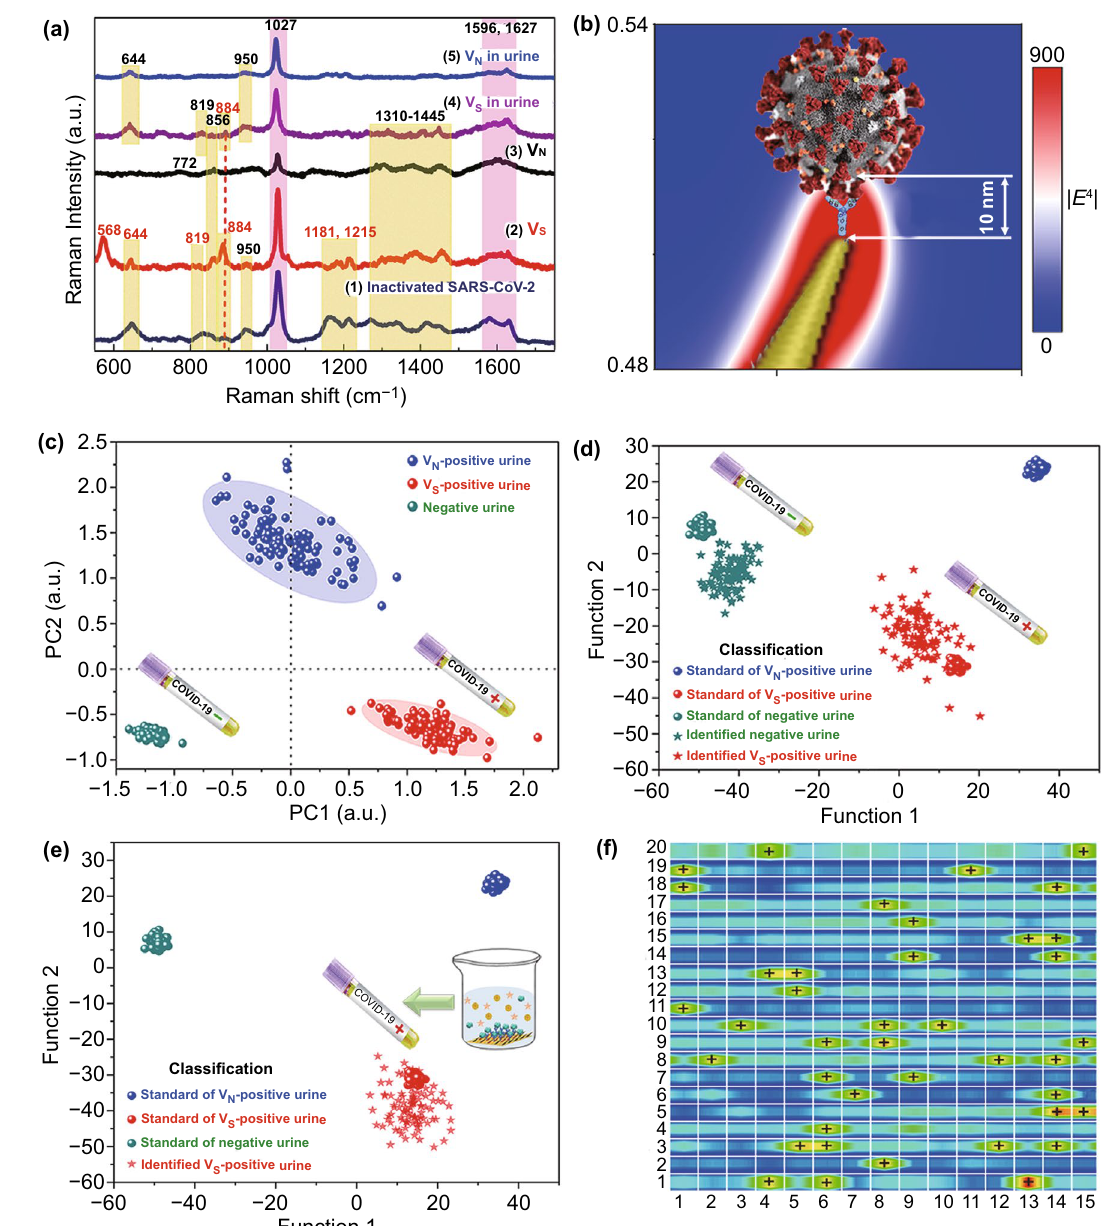
Fig. 4 Establishing and validating the SARS‑CoV‑2 virus identification standard based on machine‑learning method. a SERS spectra of inac‑ tivated SARS‑CoV‑2, V N and V S in PBS solution and urine of healthy 8‑year‑old girl patient with the viral load of 2200 copies/mL. Navy blue, red, black, purple and blue lines represent inactivated SARS‑CoV‑2, V S , V N , V S in urine and V N in urine, respectively. b Schematic of SARS‑ CoV‑2 S localized within the 10 nm EM enhancement area, and calculated intensity distribution (|E| 2 ) at 785 nm for an oblique Au nanoneedle’s tip. c Key features of SERS patterns to classify the urine samples infected by V S (simulated contaminated water by SARS‑CoV‑2 virus), V N and healthy people via PCA. d DA results to identify the urines for chronic nephritis and V S ‑containing chronic nephritis. The green, red, blue balls represent the standard of negative urine, the standard of V S ‑positive urine, the standard of V N ‑positive urine. The green and red stars rep‑ resent identified negative urine and identified V S ‑positive urine. e DA results to identify V S and V N virus mixed in the adult’s urine (2200 cop‑ ies mL −1 ). The green, red, blue balls represent the standard of V S ‑negative urine, the standard of V S ‑positive urine, the standard of V N ‑positive urine. The red star represents identified V S ‑positive urine. f SERS mapping (40 × 30 μm 2 ) of 300 measuring area for one urine sample, 42 dot‑ measuring‑area can be identified as V S